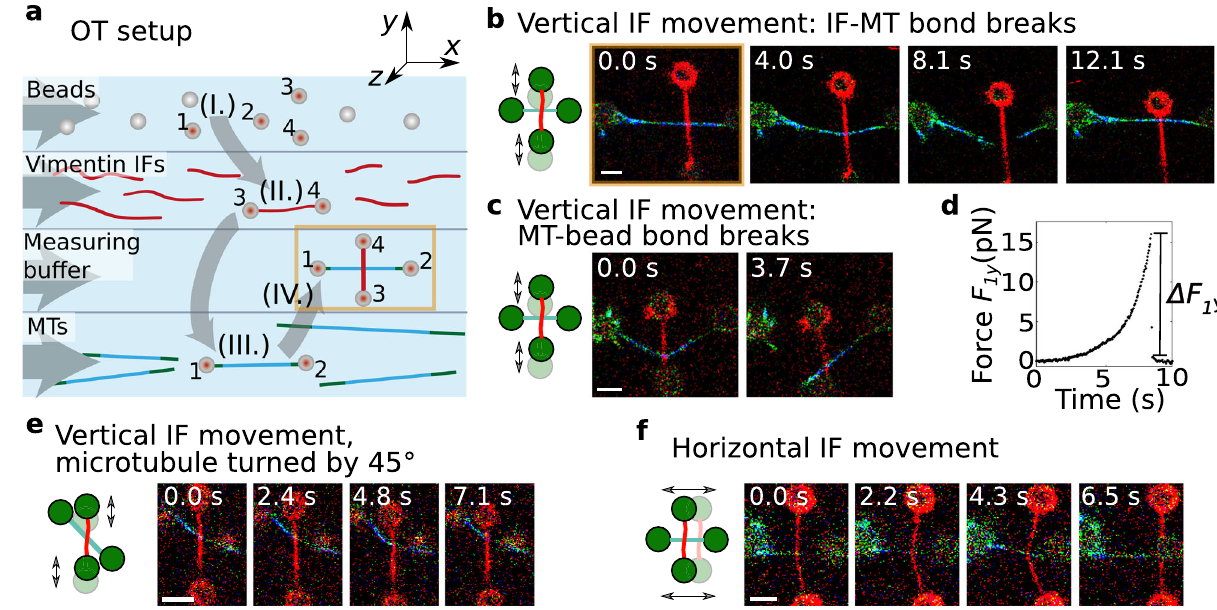
Fig. 2 Direct interactions between stabilized microtubules and vimentin IFs. a Schematic of the setup for the OT experiments for interaction measurements in micro fl uidic fl ow channels. Four streptavidin-coated beads were captured by OTs (I.). We used one bead pair (beads 3 and 4) to attach a vimentin IF (II., red), and the other bead pair (beads 1 and 2) to attach a microtubule (III., green-cyan). We brought the IF and the microtubule into contact in a crossed con fi guration (IV.). Next, we moved the IF perpendicularly to the microtubule to study the IF-microtubule interactions while we took confocal fl uorescence images (starting position marked in yellow in ( a ) and ( b )). b Typical confocal fl uorescence images of an IF-microtubule interaction which broke while the IF was moved vertically and c a strong IF-microtubule interaction for which the microtubule broke off the bead. d Typical experimental force increase F 1 y on bead 1 in the y -direction once a bond forms. Breaking of the force causes a force jump of Δ F 1 y . e Typical confocal fl uorescence images of a breaking IF-microtubule interaction at a 45 ∘ angle between them while the IF was moved vertically. f Typical confocal fl uorescence images of a breaking IF- microtubule interaction in perpendicular con fi guration while the IF was moved horizontally. Scale bars: 5 μ m. Measurements were conducted on at least three different days. Source data are provided as a Source Data fi